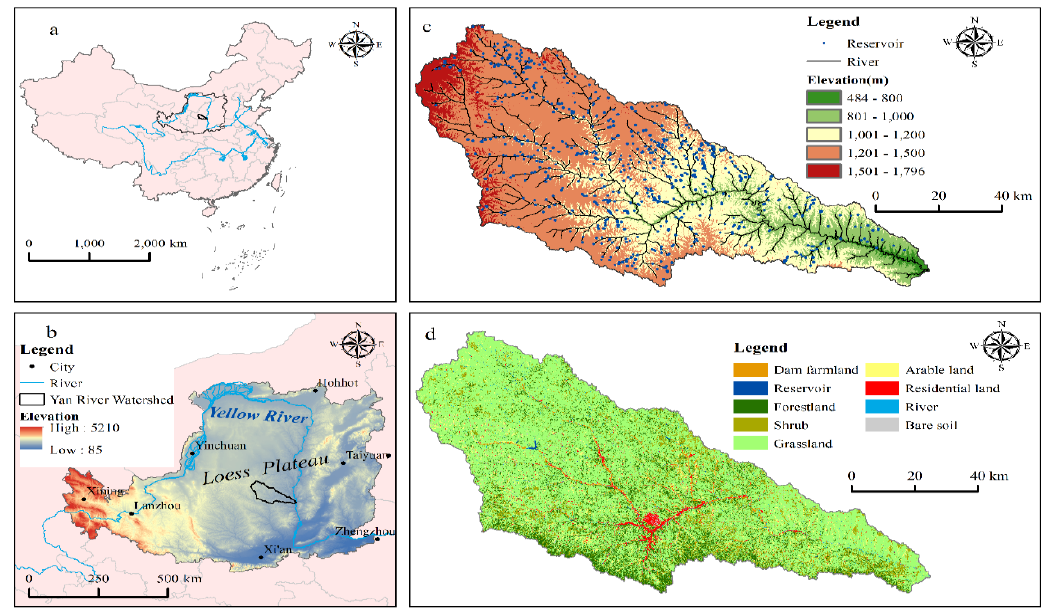
Figure 1. Location and land cover map of the Yan River watershed. ( a ) The location of the Loess Plateau in China; ( b ) the location of the Yan River watershed on the Loess Plateau; ( c ) elevation and locations of the 721 reservoirs in the Yan River watershed; and ( d ) land cover map of the Yan River watershed in 2015.